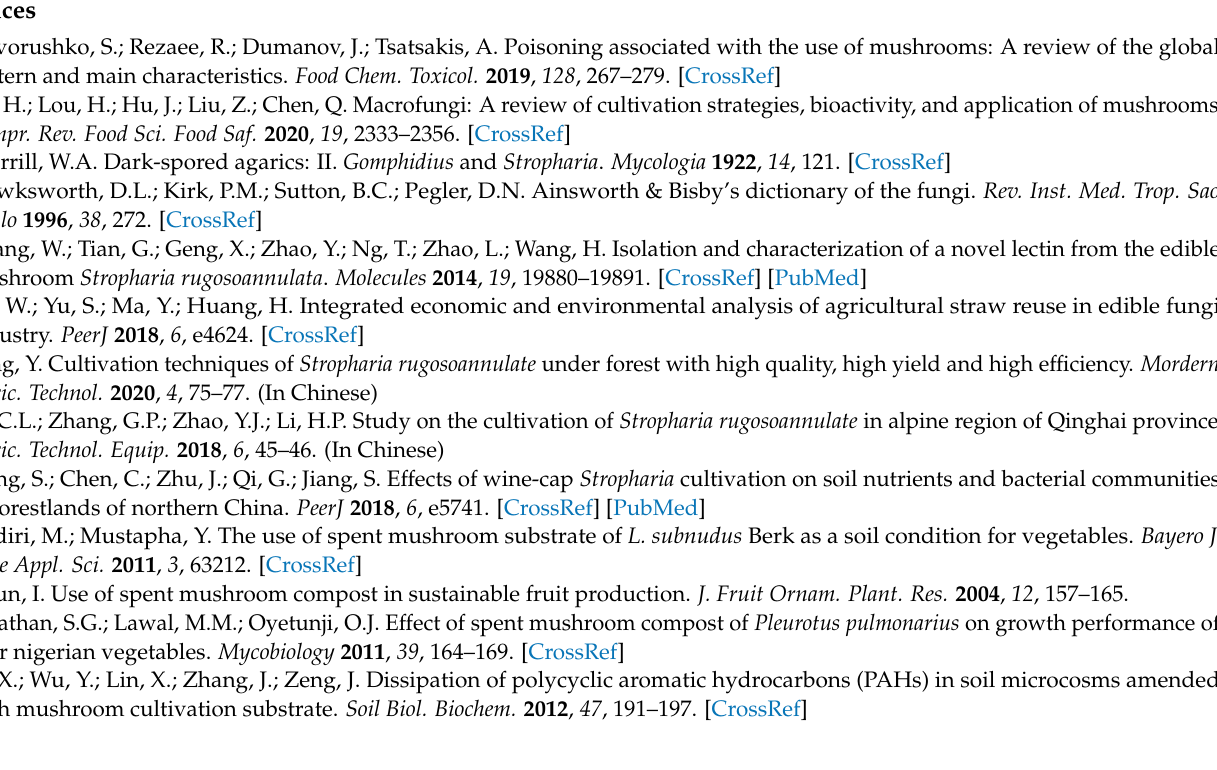
n = 4). Table S1. Relative abundances (%) of soil bacterial phylum in Stropharia rugosoannulata cultivation plots. Table S2. Relative abundances (%) of soil bacterial class in Stropharia rugosoannulata cultivation plots. Table S3. Relative abundances (%) of soil fungal phylum in Stropharia rugosoannulata cultivation plots. Table S4. Relative abundances (%) of soil fungal class in Stropharia rugosoannulata cultivation plots. Table S5. Relative abundances (%) of soil fungal genus in Stropharia rugosoannulata cultivation plots. Table S6. Microbial community functional abundance prediction based on MetaCyc genome database. The significant changed bacterial functional profiles in Stropharia rugosoannulata cultivation areas with different influencing intensities are shown in bold. Supplementary file S1: The detailed methods of soil physicochemical parameters and enzyme activities